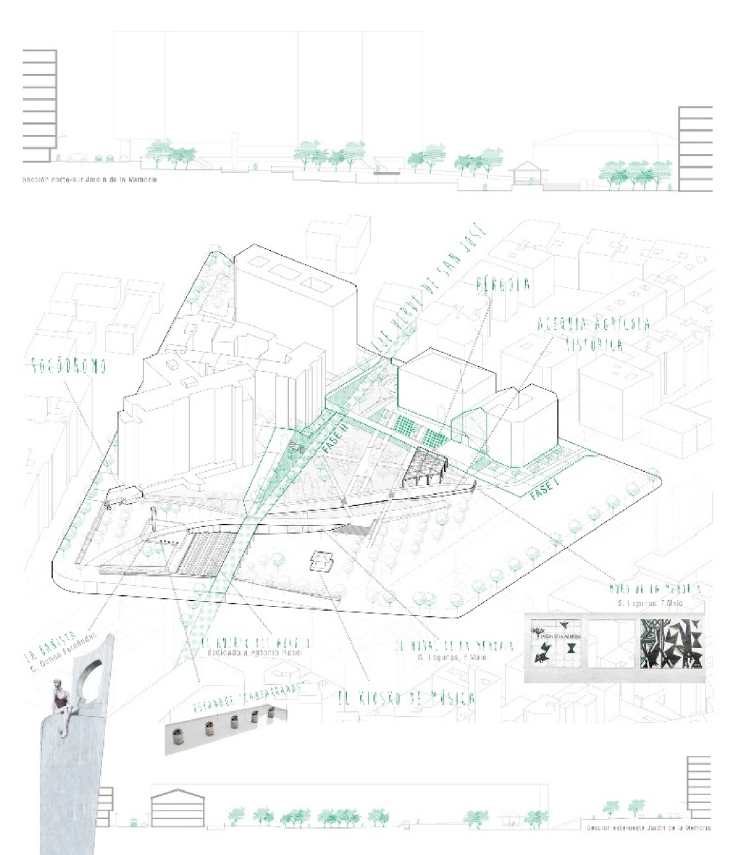
Figure 6. Work on the Jardín de la Memoria superblock (San José Alto) (Students: I. Fernández & M.